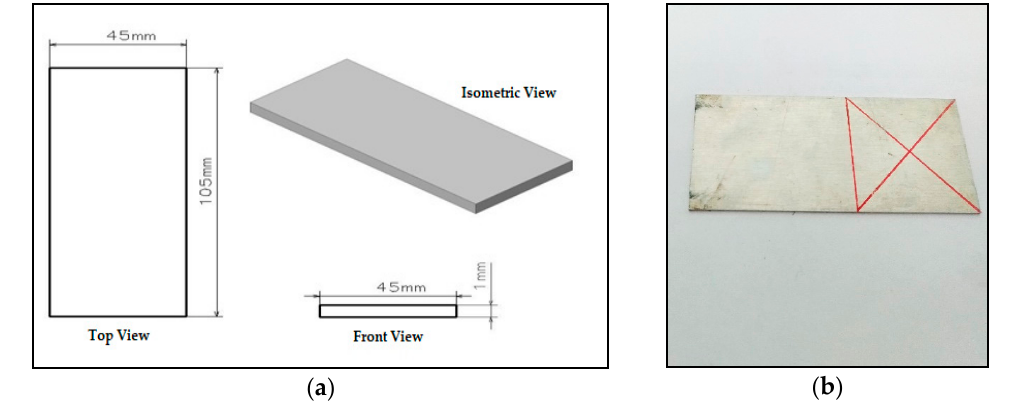
Figure 1. Dimensions ( a ) and image ( b ) of test sample.